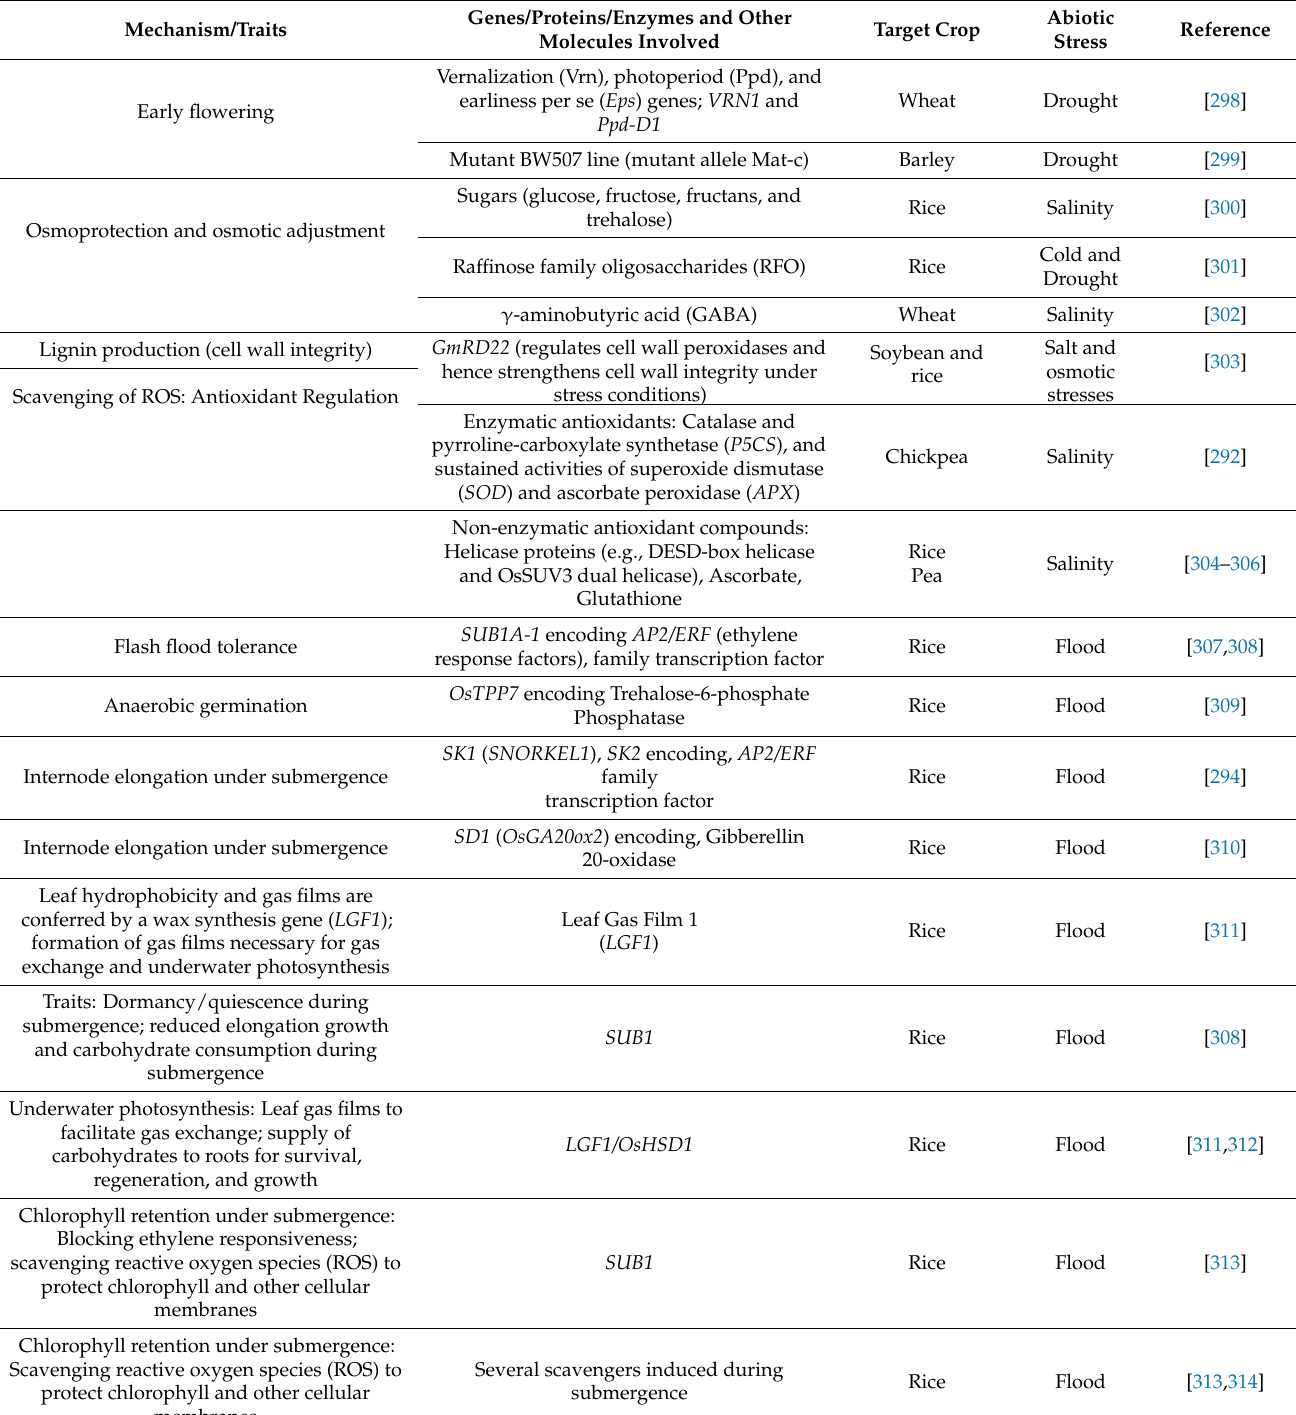
Table 6. Explored mechanisms involved in tolerance to different abiotic